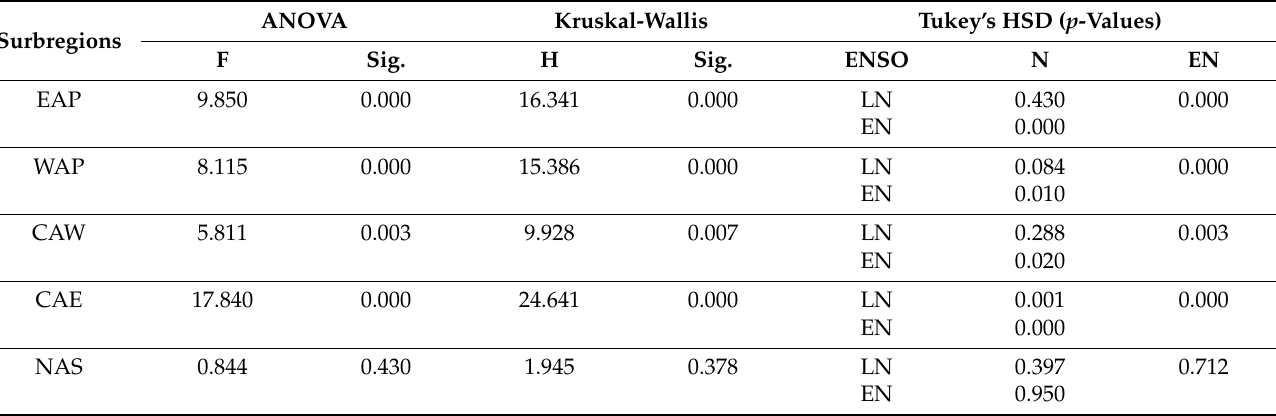
Figure 5. Mean monthly anomalies during the EN and LN events for the subregions during 1980 – 2021. The error bars represent the standard error of the mean for each ENSO condition in a subregion. The values during the normal (labeled as N) conditions are also included for comparison. Table 3. Results of One-Way ANOVA comparing the means of dust column mass density anomalies between the EN (N = 84), LN (N = 84), and normal (N = 336) months during 1980 – 2021.